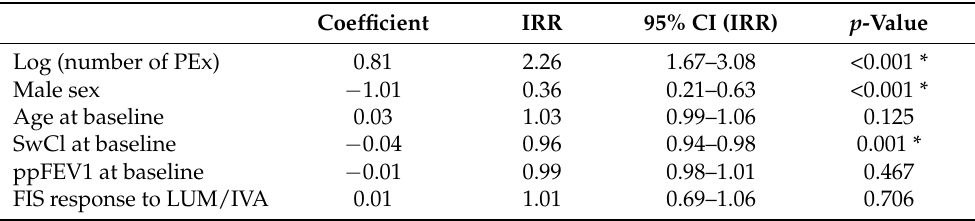
Figure 1. Predicted ppFEV1 decline before and after CFTR modulator initiation at varying ages and varying numbers of PEx. Plots are based on the linear mixed effects model coefficients in Table 2 to illustrate the associations of ppFEV1 decline with age at baseline ( a ) and with PEx ( b ). Time ranges from − 3 years before to +3 years after LUM/IVA initiation, with time = 0 (baseline) defined by the start date of treatment with LUM/IVA. Model estimates suggested a faster ppFEV1 decline at a younger age which diminished at an older age. This is illustrated for an age at baseline of 18 years and 30 years ( a ), while all other covariates were kept constant at their mean or median values or at the reference category (as reported in Table 1). In addition, predicted ppFEV1 decline was plotted for pwCF without PEx vs. with 3 PEx in the three years before LUM/IVA initiation ( b ), to illustrate that predicted ppFEV1 decline may deteriorate with an increasing number of PEx. Model performance: conditional R 2 0.95, marginal R 2 0.34. Table 3. Multivariable negative binomial model of total number of PEx requiring IV antibiotics in the first three years after LUM/IVA initiation ( n =